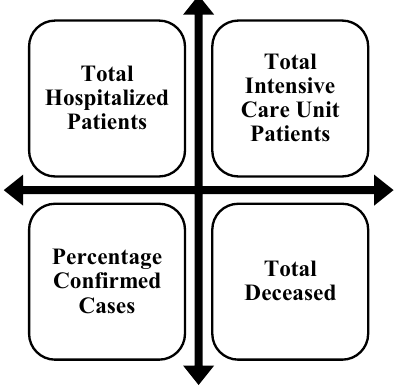
Figure 1. Model of COVID-19 related morbidity and